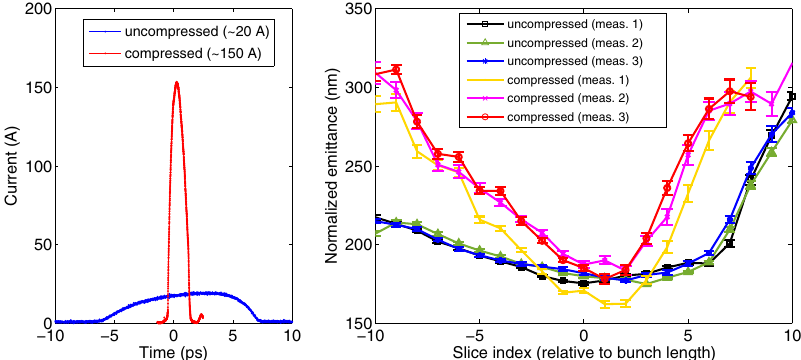
FIG. 65. Current profiles (left plot) and three consecutive slice emittance measurements (right plot) for uncompressed and compressed beams (compression factor 7.5). The longitudinal extension of a slice is a fixed fraction of the rms bunch